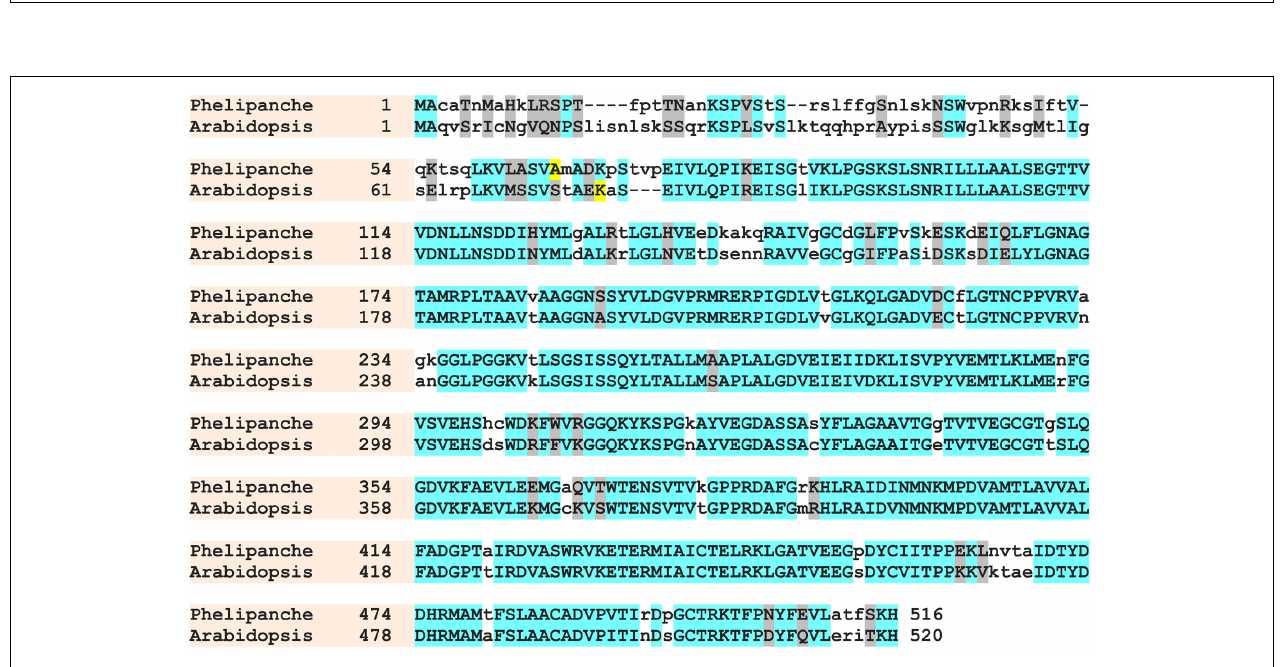
FIGURE 1 | Amino acid sequence alignment of A. thaliana ( Arabidopsis ) and P. aegyptiaca ( Phelipanche ) ALS. Identical and similar amino acids are shown in azure and gray, respectively. Non-identical amino acids are shown in lowercase letters. First amino acids of predicted mature protein are shown in yellow.